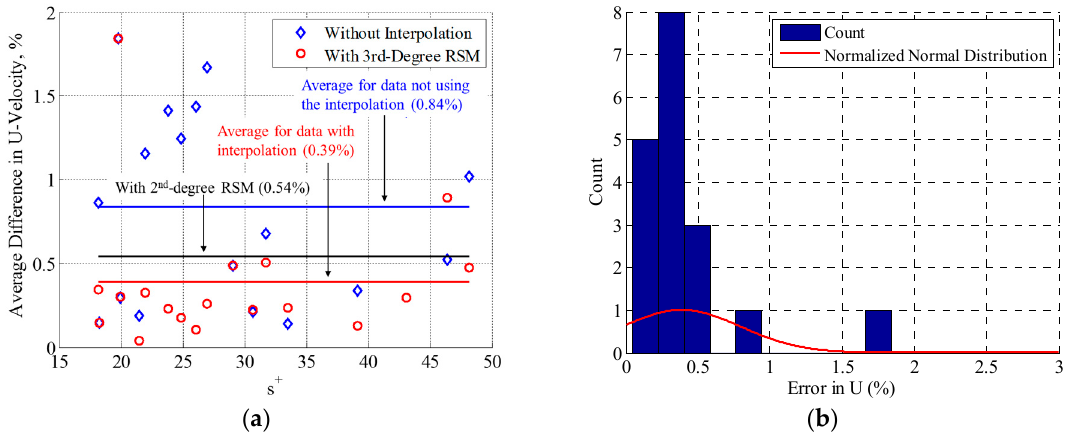
Figure 11. ( a ) Average difference for U -velocity compared between reference case and compared case plotted against s + ; and ( b ) histogram of average error in U -velocity.